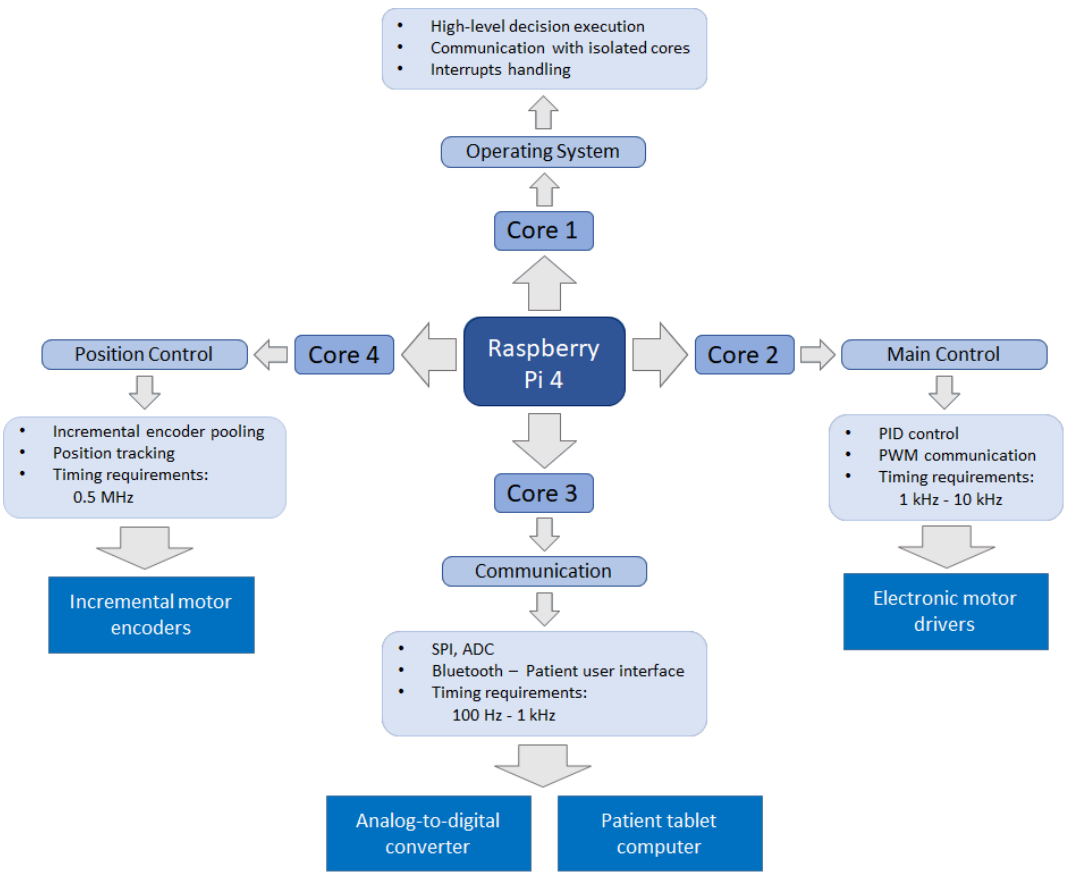
Figure 3. Multithreaded approach to robot control and embedded hardware